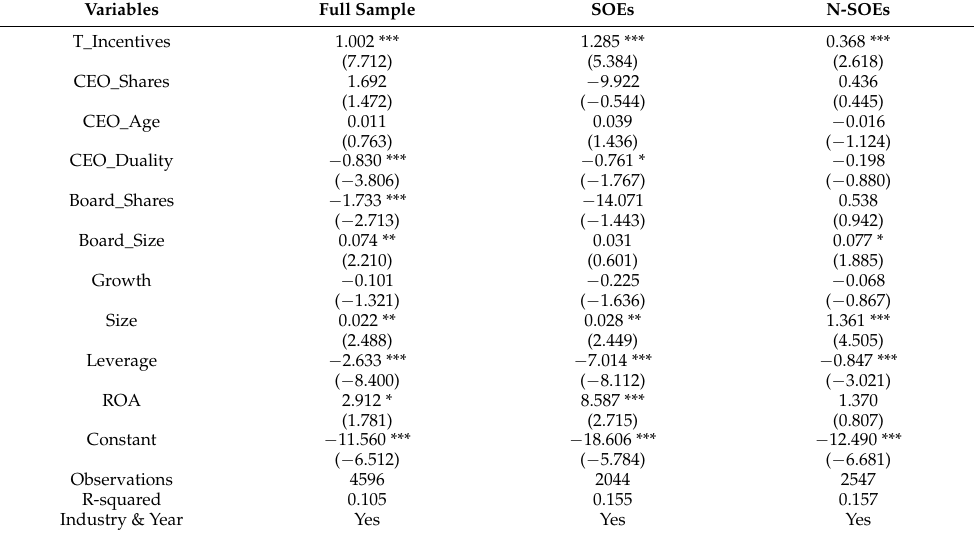
Table 7. Two Stage least squares (2SLS)